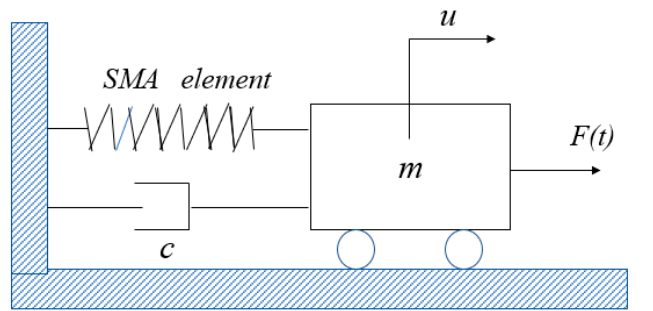
Figure 1. Stochastic dynamic model of shape memory alloys oscillator .